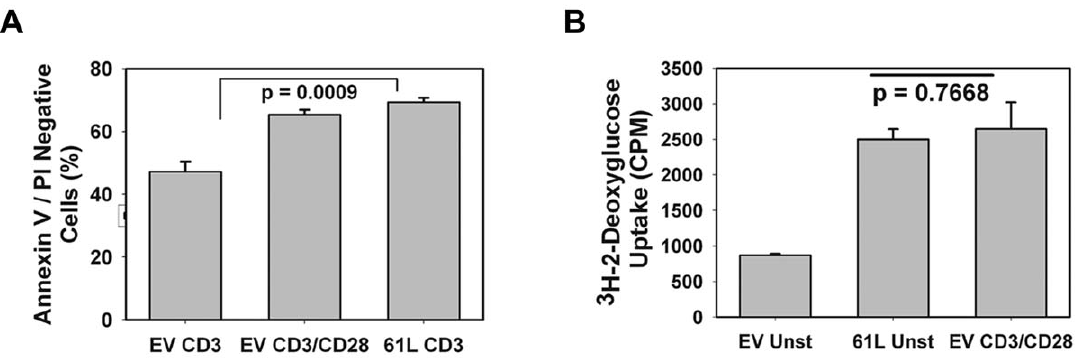
Figure 4. Active Ras can recapitulate CD28-mediated cell survival and increased glucose uptake. A. CAR Tg Th1 cells were transduced with empty vector or Ras61L and stimulated with antibody-coated beads in triplicate as indicated. Cells were analyzed for survival after 48 hours by staining with FITC-annexinV and propidium iodide followed by flow cytometry. P value indicates significantly increased AnnexinV/PI negative (live) cells when active Ras is added to CD3 stimulation. B. CAR Tg Th1 cells were transduced as in A and left unstimulated or stimulated in triplicate overnight (20 h) as indicated. Cells were pre-incubated in glucose uptake buffer and then exposed to 3 H-2-deoxy-glucose ( 3 H-2-DOG) for 2 minutes. 3 H-2-DOG uptake was measured in a ß-scintillation counter. P value indicates no significant difference in glucose uptake by unstimulated Ras- transduced cells and empty vector-transduced cells stimulated with anti-CD3 and anti-CD28 antibodies. For all data shown in this figure, error bars represent standard deviation between triplicates samples from the same experiment.